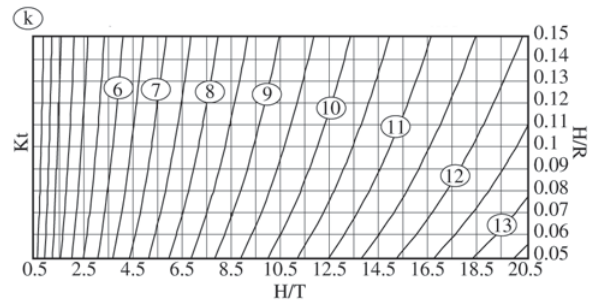
Figura 5. Kt en función de H/T y H/R para A/T = 0.05